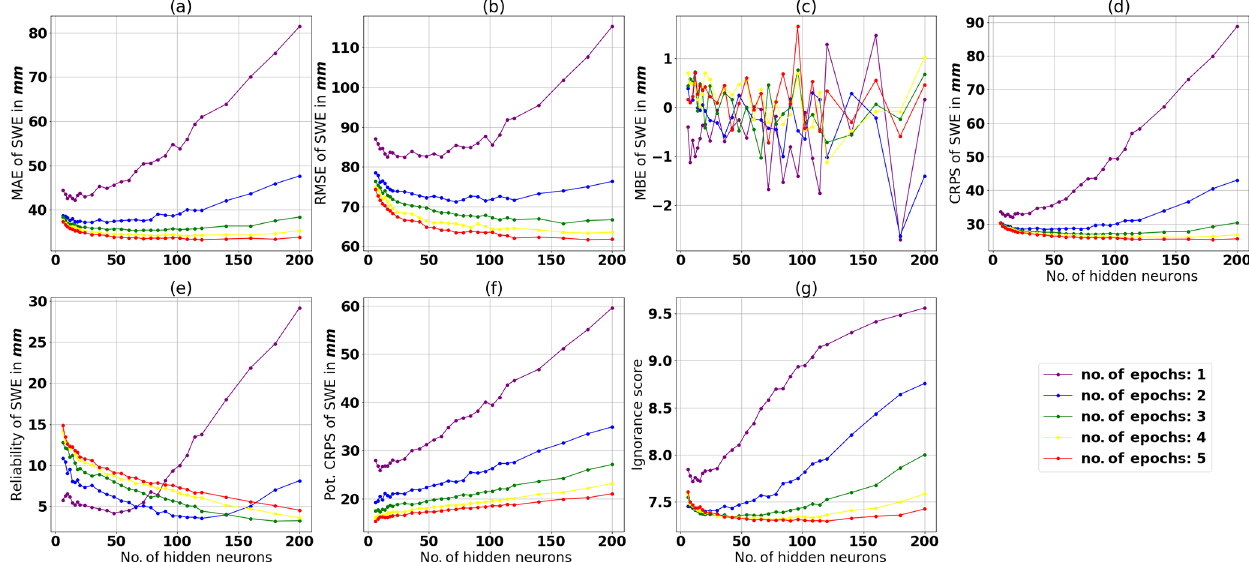
Figure 8. Results using the Combo setup from Table 3 for different numbers of training epochs and neurons in the hidden layer. It shows (a) the MAE, (b) the RMSE, (c) the MBE, (d) the CRPS, (e) the reliability part of the CRPS, (f) the potential CRPS, and (g) the ignorance score. The scores are evaluated on the validation data set.